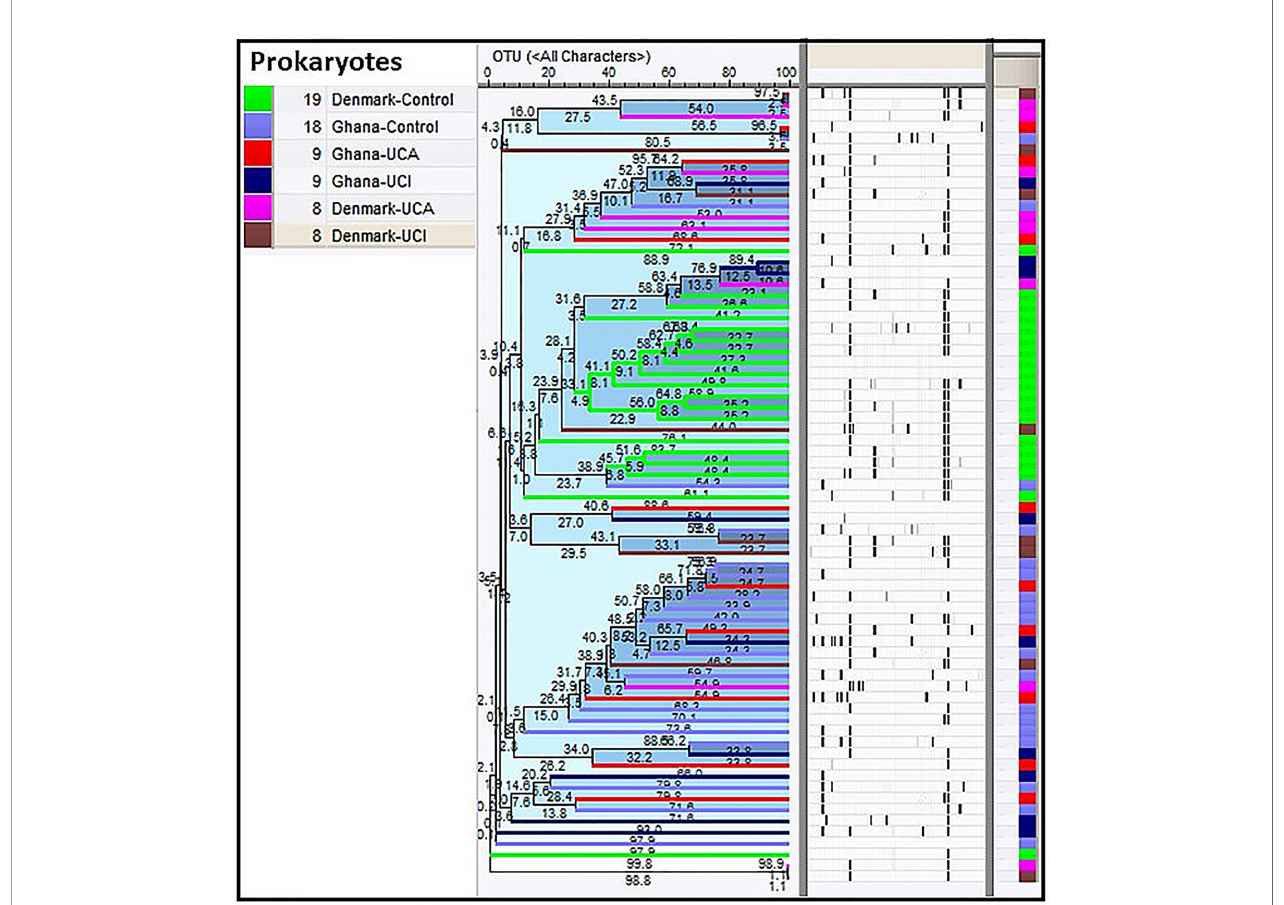
FIGURE 1 | Cluster analysis of prokaryotes in study groups show healthy controls from Denmark are clustered together in the middle of the dendrogram (in green), while 16 of the healthy controls from Ghana are clustered together with patients from Ghana in the bottom of the